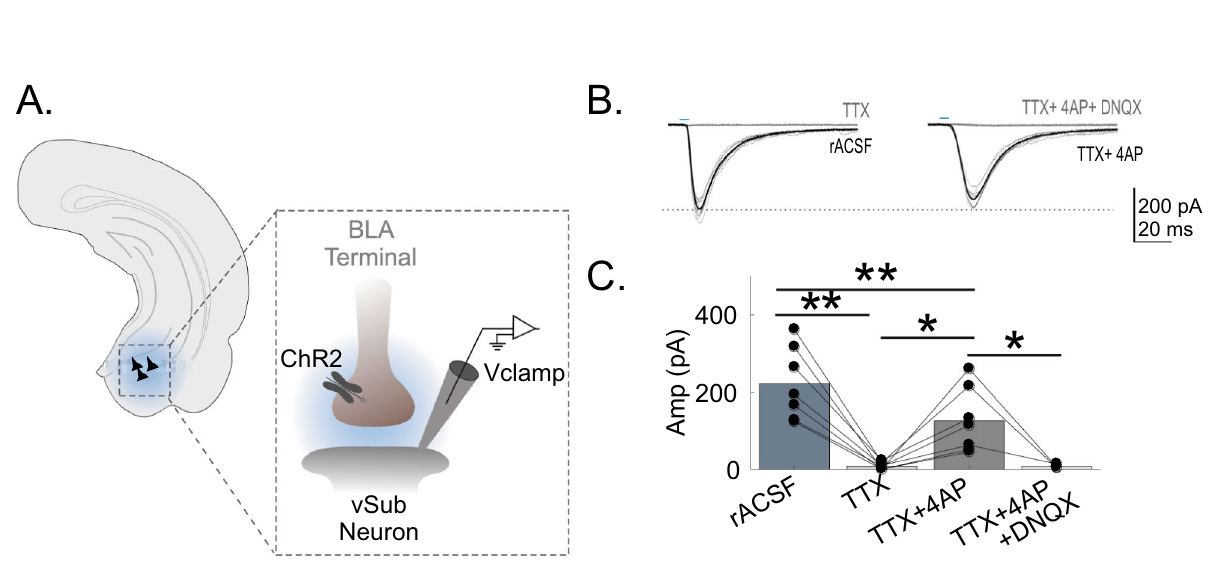
Figure 1. vSub neurons receive monosynaptic input from the BLA. ( A ) Schematic representation of recording configuration. Schematic line drawing of the hippocampus is adapted from Paxinos and Watson (2005) with permission 26 . ( B ) Representative oEPSCs in rACSF (black traces), during bath application of TTX (gray traces) on the right and bath application of TTX and 4AP (black traces) and TTX, 4AP and DNQX (gray traces). In representative traces, individual oEPSCs are shown by thin lines while the average response is illustrated by a thicker overlaid line. Blue bars above figures illustrate onset and duration of optical stimulation. ( C ) Optically- evoked input is abolished by TTX, reinstated by TTX + 4AP, and can be blocked by DNQX. *p < 0.05 and **p < 0.01 and errors are reported as ±